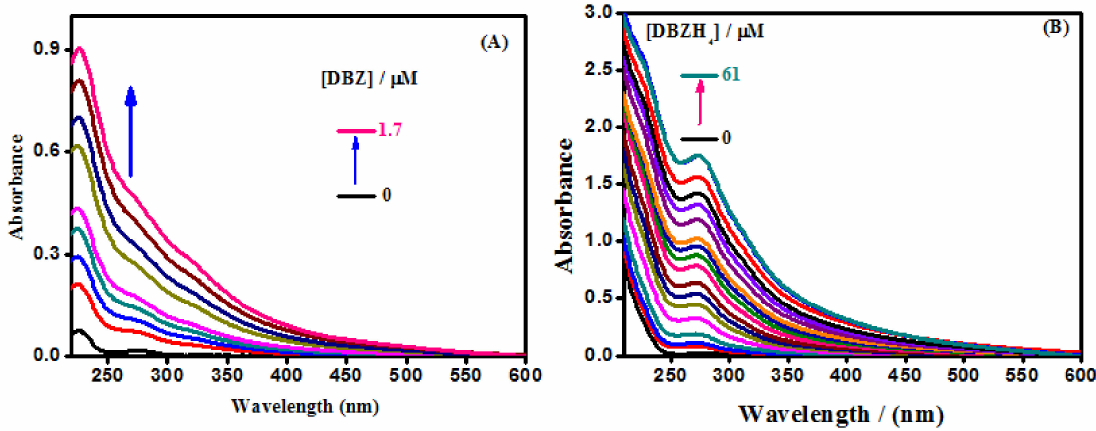
Figure 2. Absorption spectra of BSA (19 µ M) in the presence of different concentrations of ( A ) DBZ and ( B ) DBZH 4 in water; Arrow indicates the increasing concentration of the complexes.